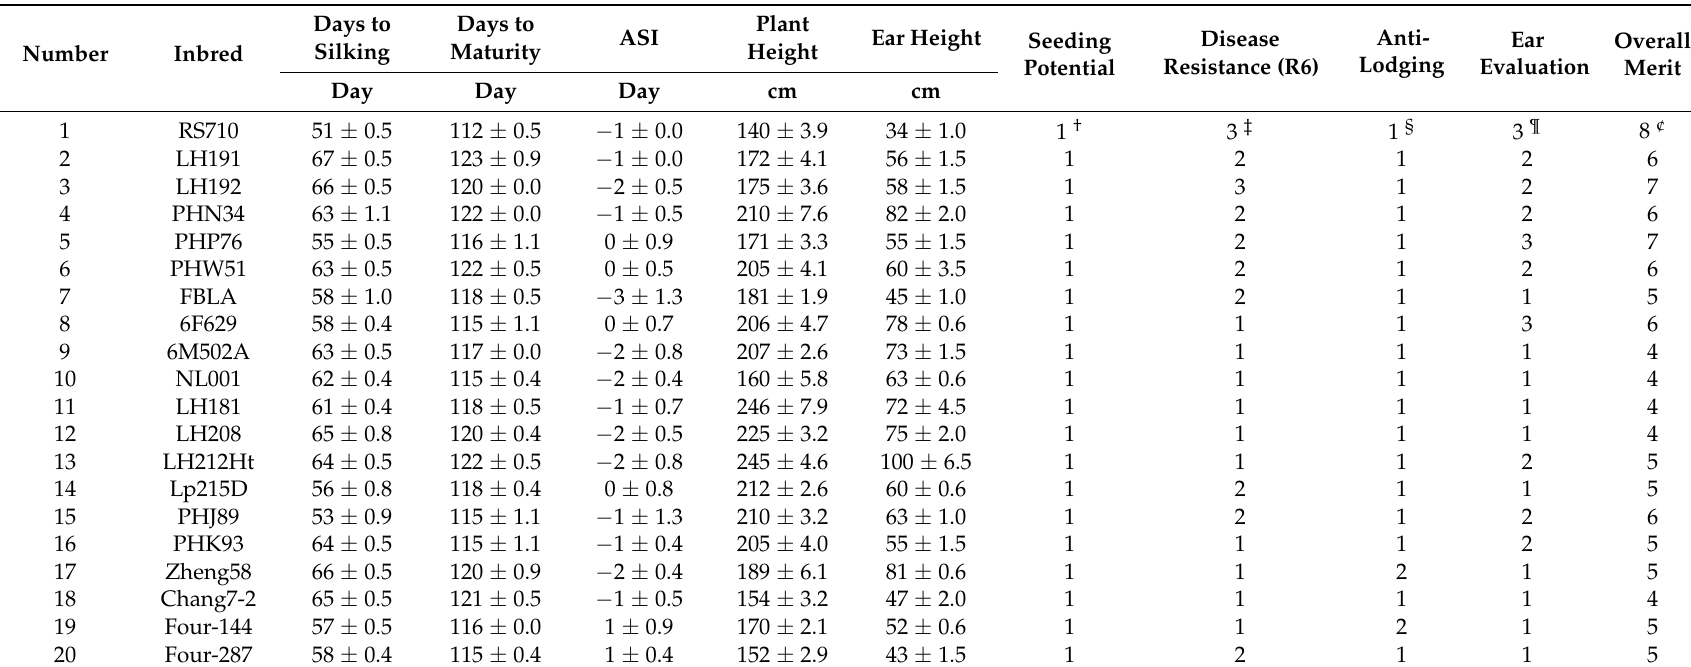
Table 5. Field characteristics and adaptability of the sixteen USA inbreds and four China inbreds in Tongliao. Values are the average ± 1 standard